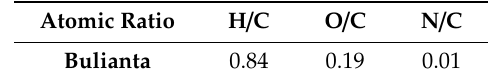
Table 2. The ratio of the mumber of atoms.